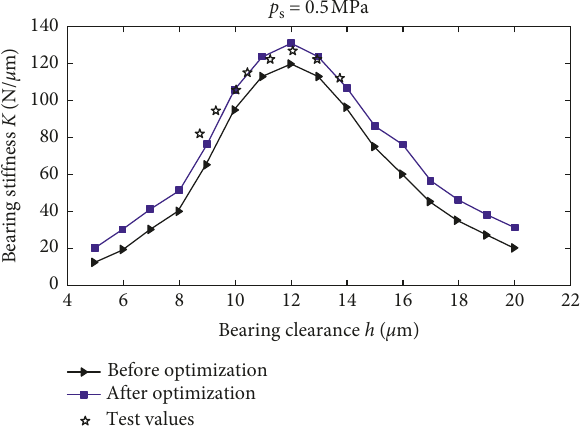
Figure 13: Comparison of bearing